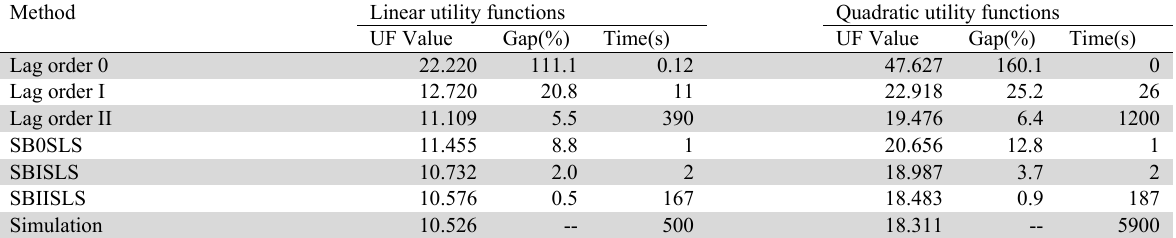
Optimization results of SBKSLS compared with lag order method and simulation. (cid:1840) (cid:3404) 11 , i.i.d. exponential (CV=1) service times Method